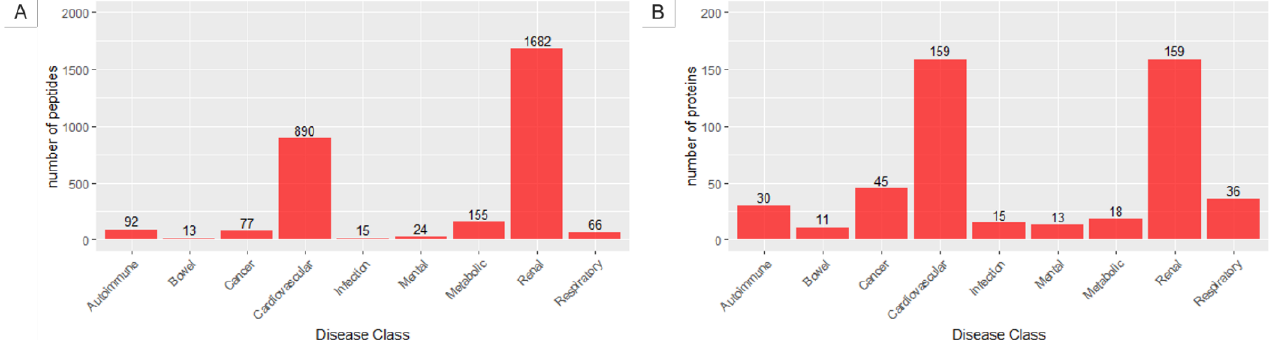
Figure 1. Distribution of unique peptides ( A ) and proteins ( B ) across the different disease classes.